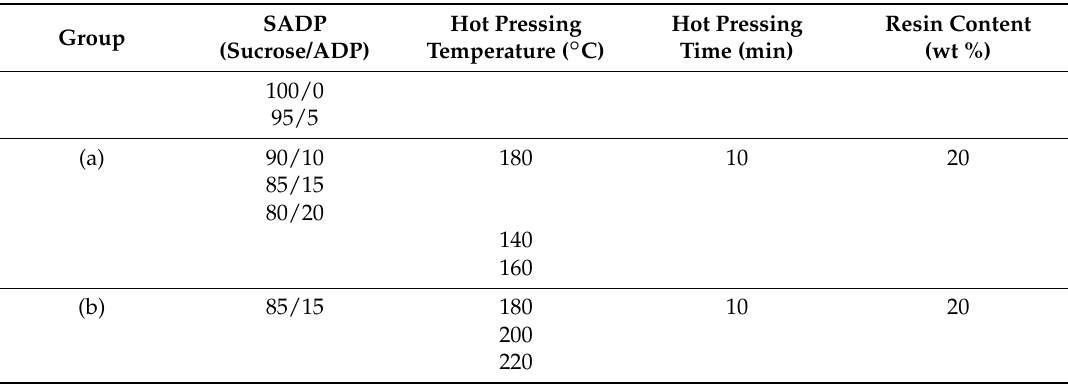
Table 2. Manufacture conditions of the